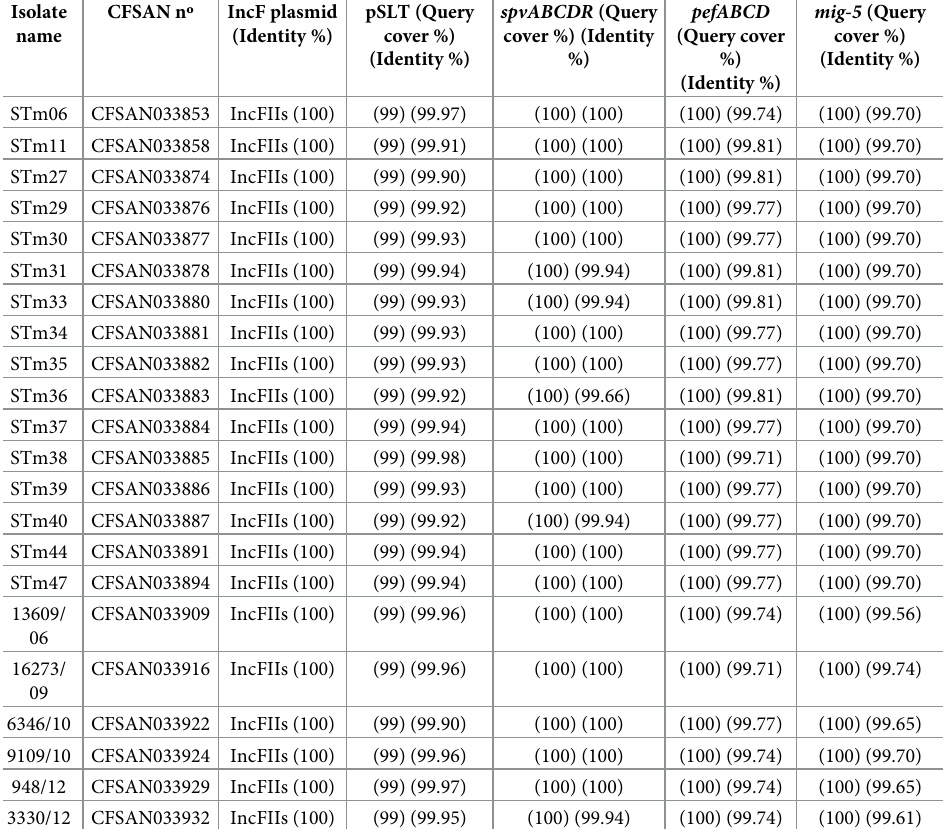
Table 4. PlasmidFinder and BLASTn of 22 Salmonella Typhimurium isolates that presented the pSLT plasmid carrying the plasmid genes